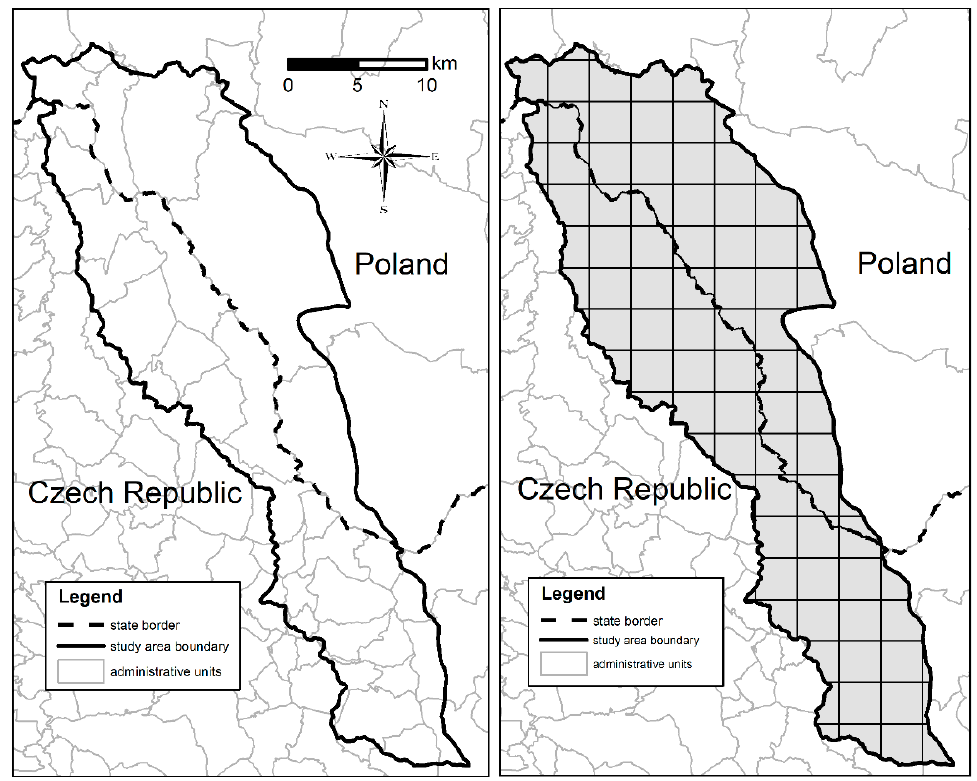
Figure 2. The study area against the background of the administrative division ( left ) divided into a square grid ( right ).